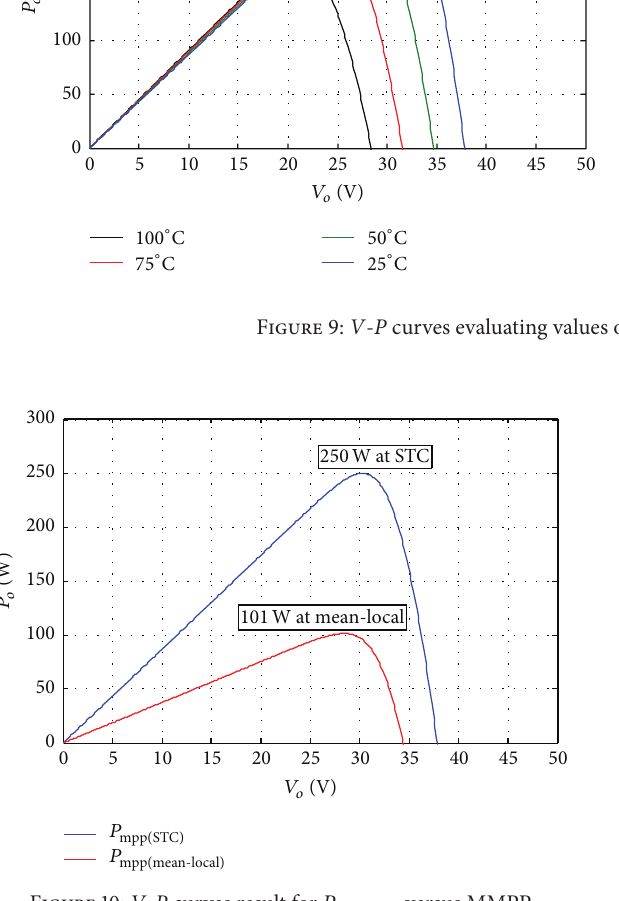
Figure 10: V - P curves result for 𝑃 mpp ( STC ) versus MMPP.